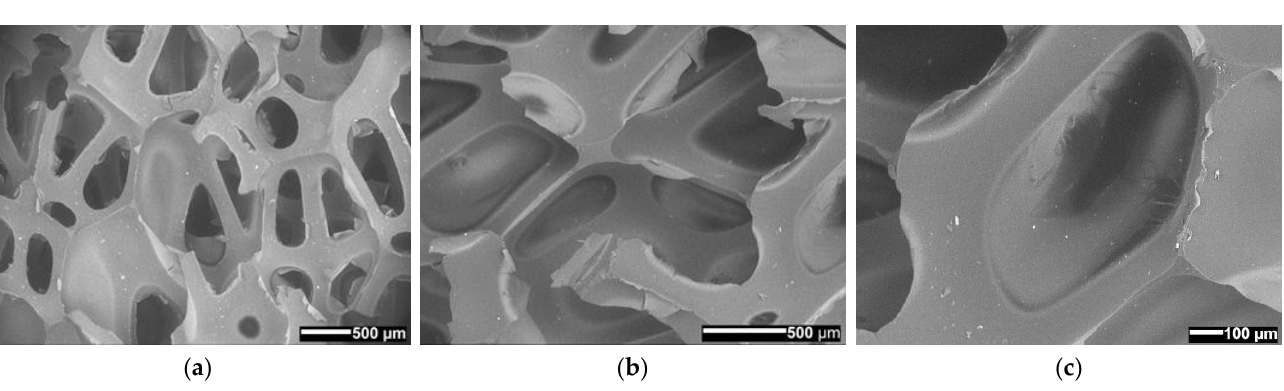
Figure 15. SEM micrographs of the surface of expanded solid polymer PUR 0 sample; at magnification ( a ) 30×, ( b ) 50×, and ( c ) 100×.